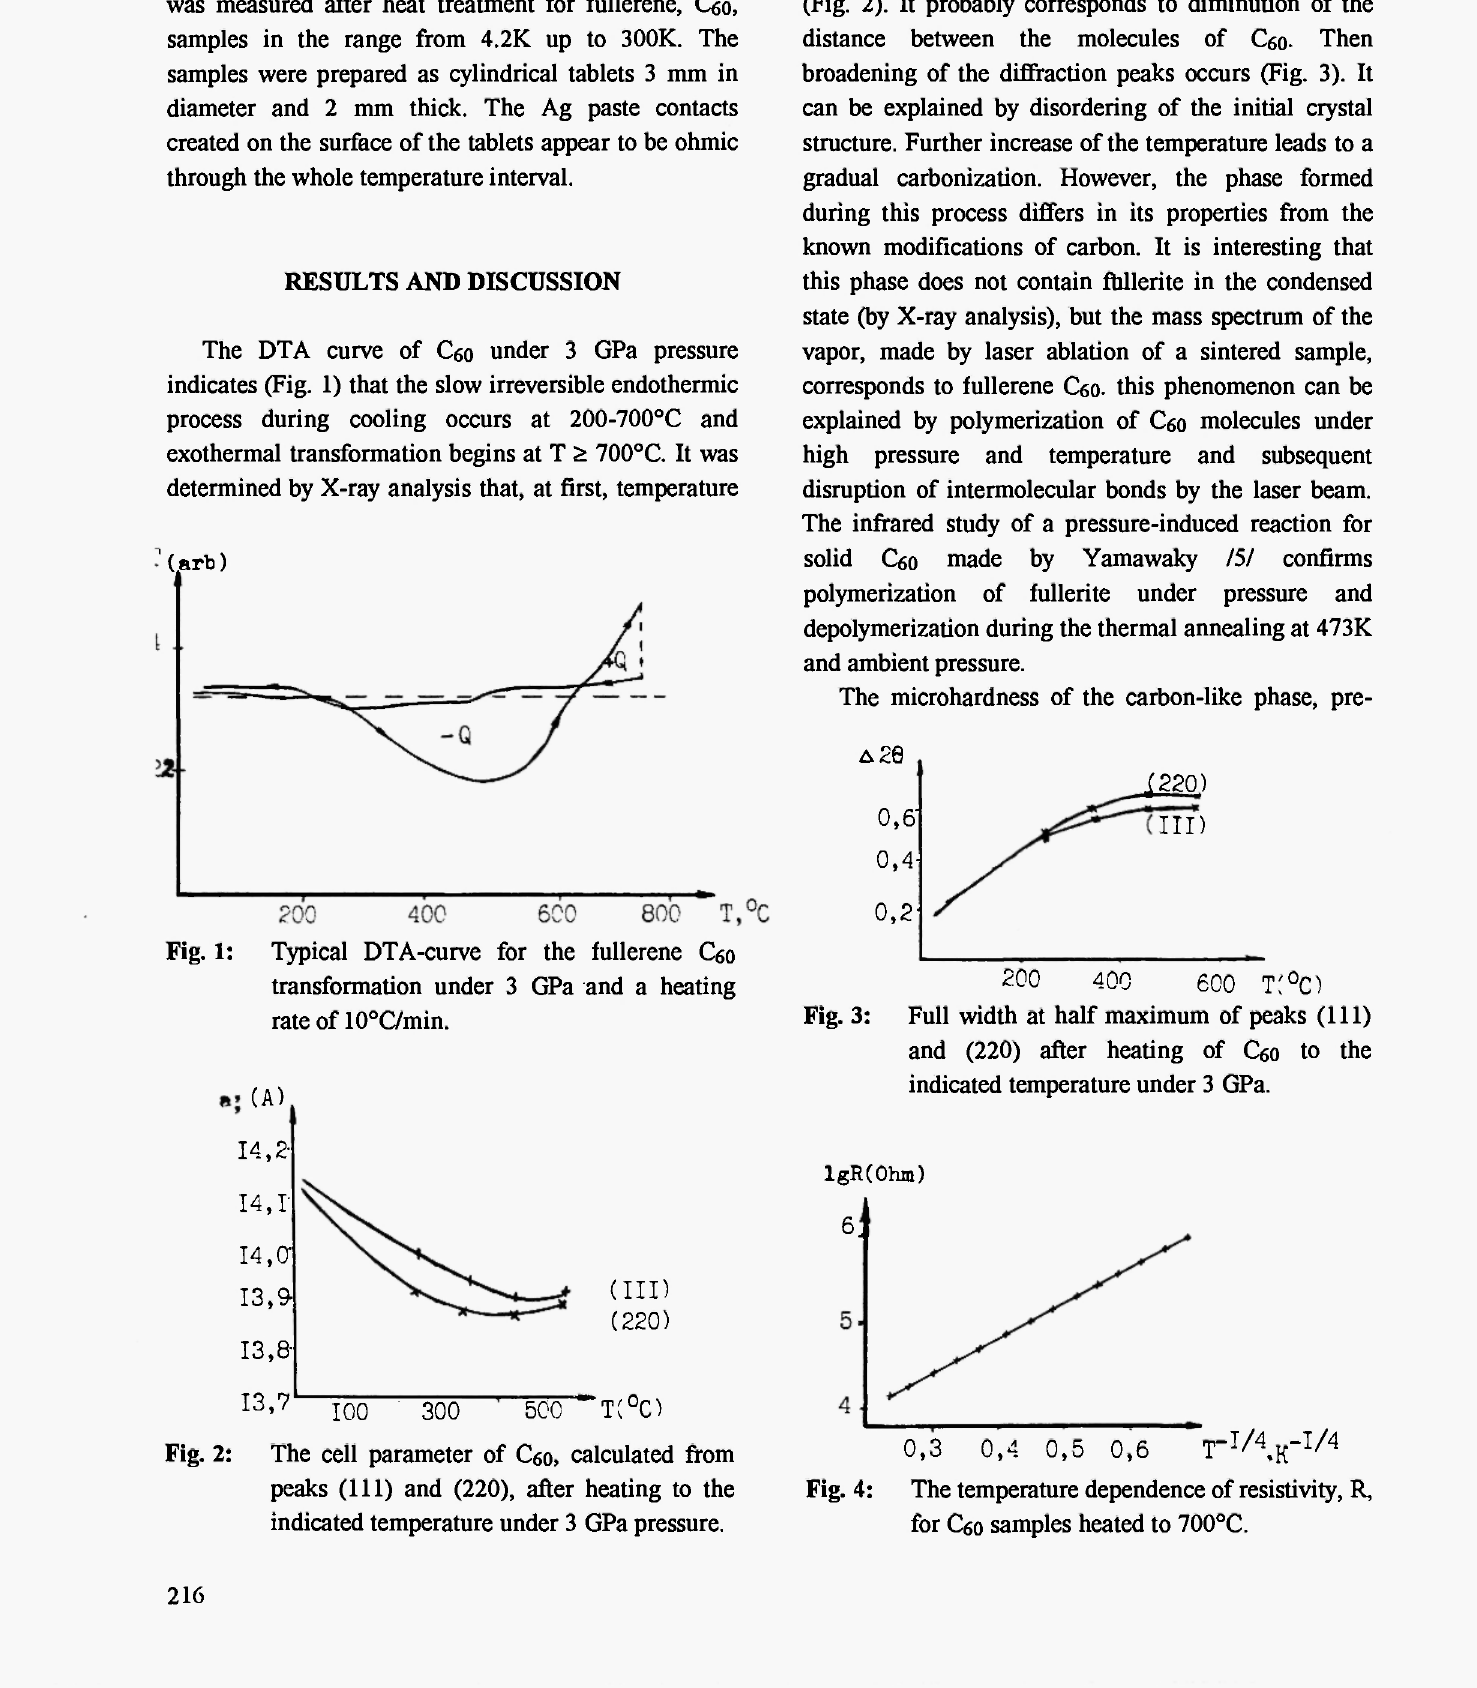
Fig. 4: The temperature dependence of resistivity, R, for Cöo samples heated to